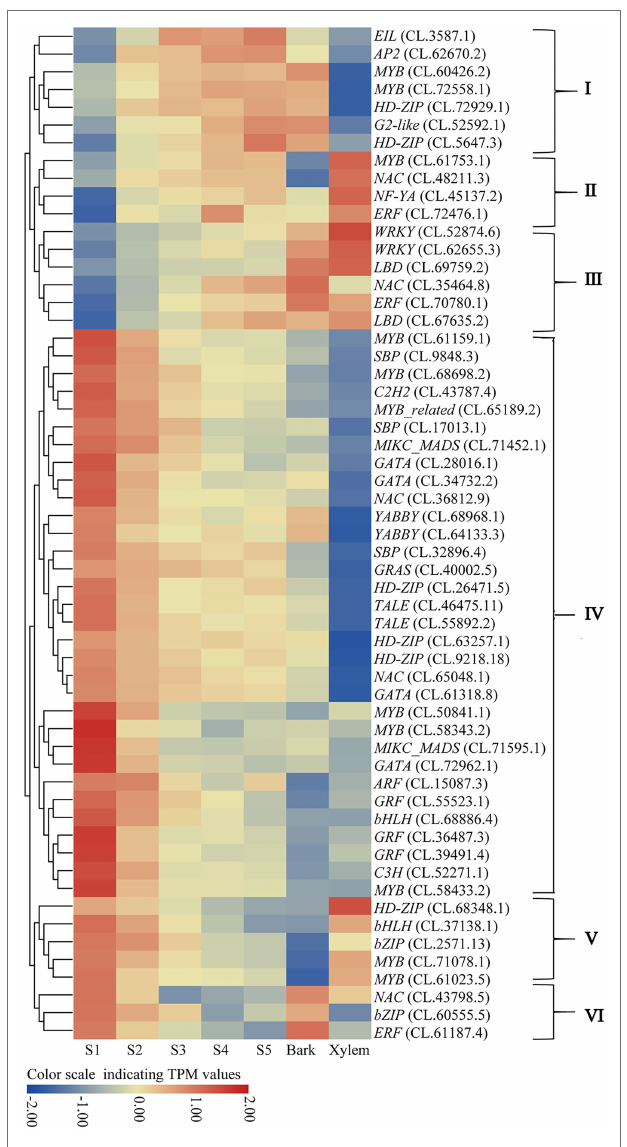
FIGURE 6 | The expression patterns of identified TFs by WGCNA. (I) Upregulated expression from S1 to S5 and significant expression in bark; (II) upregulated from S1 to S5 and significant expression in xylem; (III) upregulated expression from S1 to S5 and no significant expression in bark and xylem; (IV) downregulated from S1 to S5 and no significant expression in bark and xylem; (V) downregulated from S1 to S5 and significant expression in xylem; (VI) downregulated from S1 to S5 and significant expression in